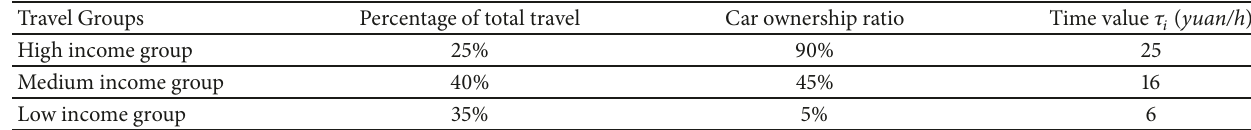
Table 2: Relevant data of different travel